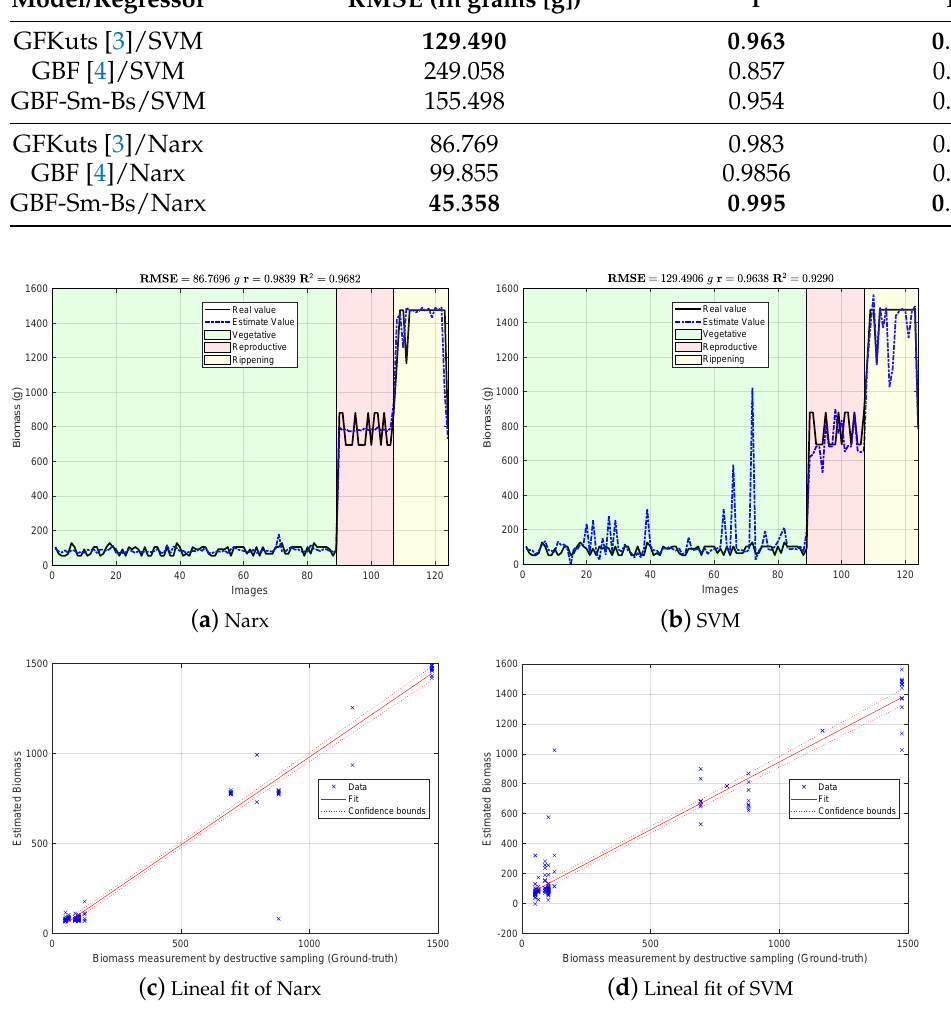
Figure 4. Biomass estimation using the GFKuts